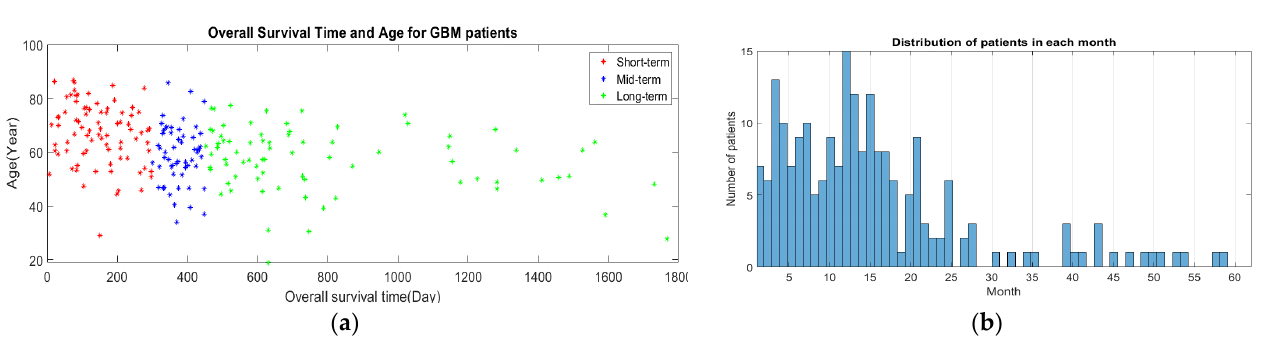
Figure 3. Survival distribution for BraTS 2019 dataset, ( a ) patients’ age and the overall survival time, ( b ) number of pa- tients in each month.